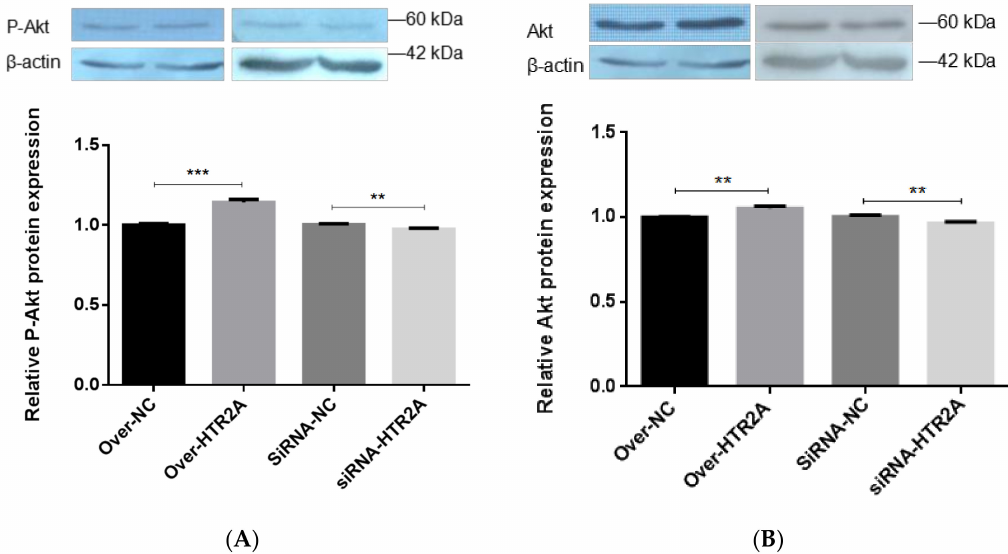
Figure 8. HTR5A affects Akt protein expression and phosphorylation. ( A ) The protein expression levels of phospho-AKT (Ser473) were evaluated after introduction; ( B ) the protein expression levels of Akt was evaluated after introduction; the level of total β -actin was determined as a loading control. The lanes in all of the Western blots were overexpression control, overexpression, knockdown control, and knockdown group from left to right. Values are means ± SD. vs. control group, ** p < 0.01; *** p <